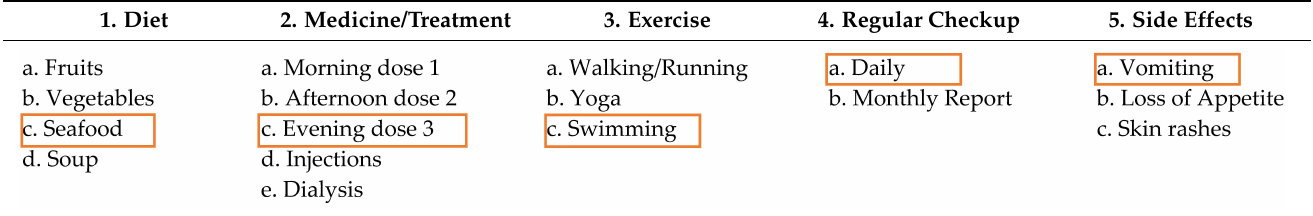
Table 8. XAI Personal Post-Treatment Recommendation Chart for AKI